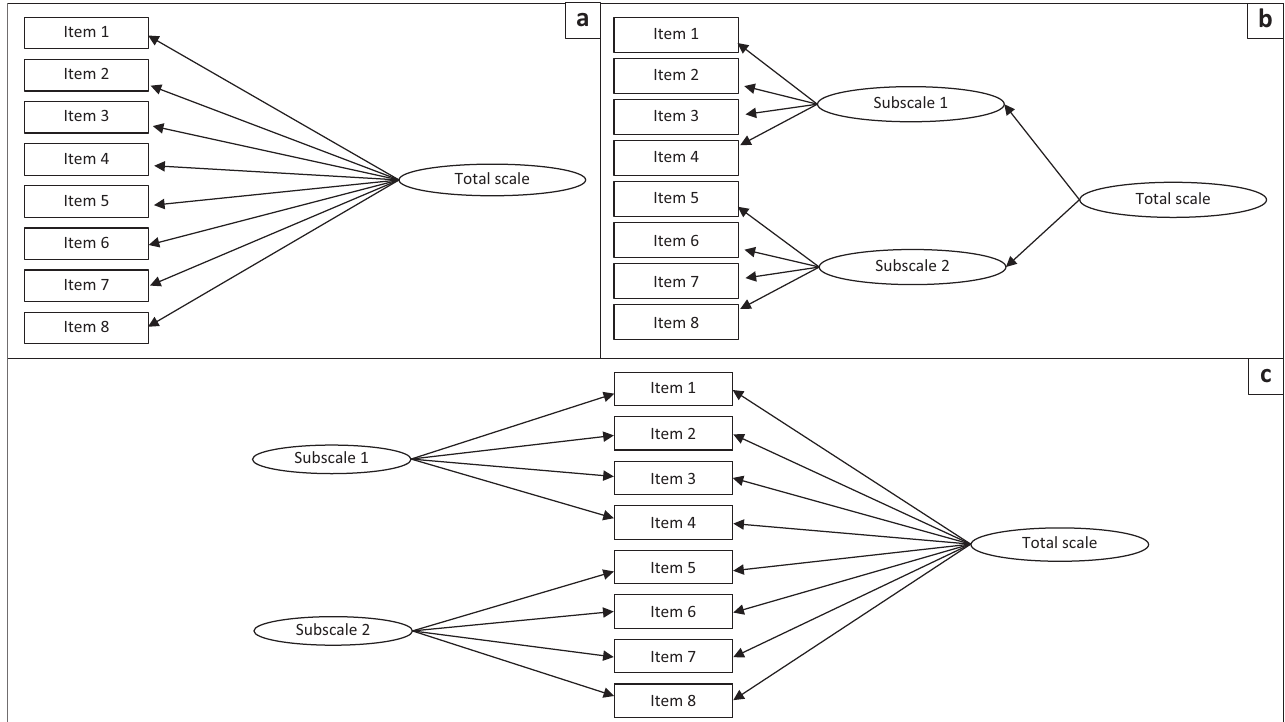
FIGURE 1 : Three conceptualisations of the factor structure of a hypothetical eight-item scale. (a) One-factor model, rectangles are observed variables. Ellipse is latent variable; (b) Second-order factor model and (c) bifactor